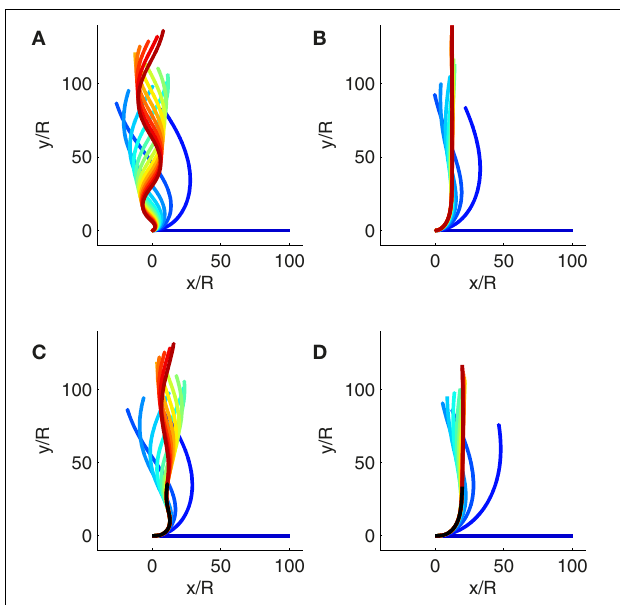
FIGURE 5 | Simulations of gravitropic growth. The color (from blue to red) codes for the elapsed simulation time. (A) Solution of the AC ˙ E model during exponential growth when B = 10, ˜ γ = 0 . 1 and L 0 / R = 100. The simulated organ does not reach a steady state. The size of the curved zone is expanded by growth and the organ cannot regulate its posture (Movie 1). (B) Solution of the AC ˙ E model during exponential growth when B = 10, ˜ γ = 10 and L 0 / R = 100. The simulated organ reaches a steady state even if the organ is elongating (Movie 2). (C) Solution of the AC ˙ E model during subapical growth when B = 10, ˜ γ = 0 . 1, and L gz / R = 100. The black curve is the part of the organ that is outside the growth zone where the curvature cannot be modified. As the simulated organ reaches the vertical, oscillations are fixed on the final shape due to the elements convected outside the growth zone (Movie 3). (D) Solution of the AC ˙ E model during subapical growth when B = 10, ˜ γ = 10, and L gz / R = 100. The black curve is the part of the organ that is outside the growth where the curvature cannot be modified. The simulated organ reaches a steady state before the elements of the organ are convected outside of the growth zone. No oscillations are fixed on the final shape (Movie